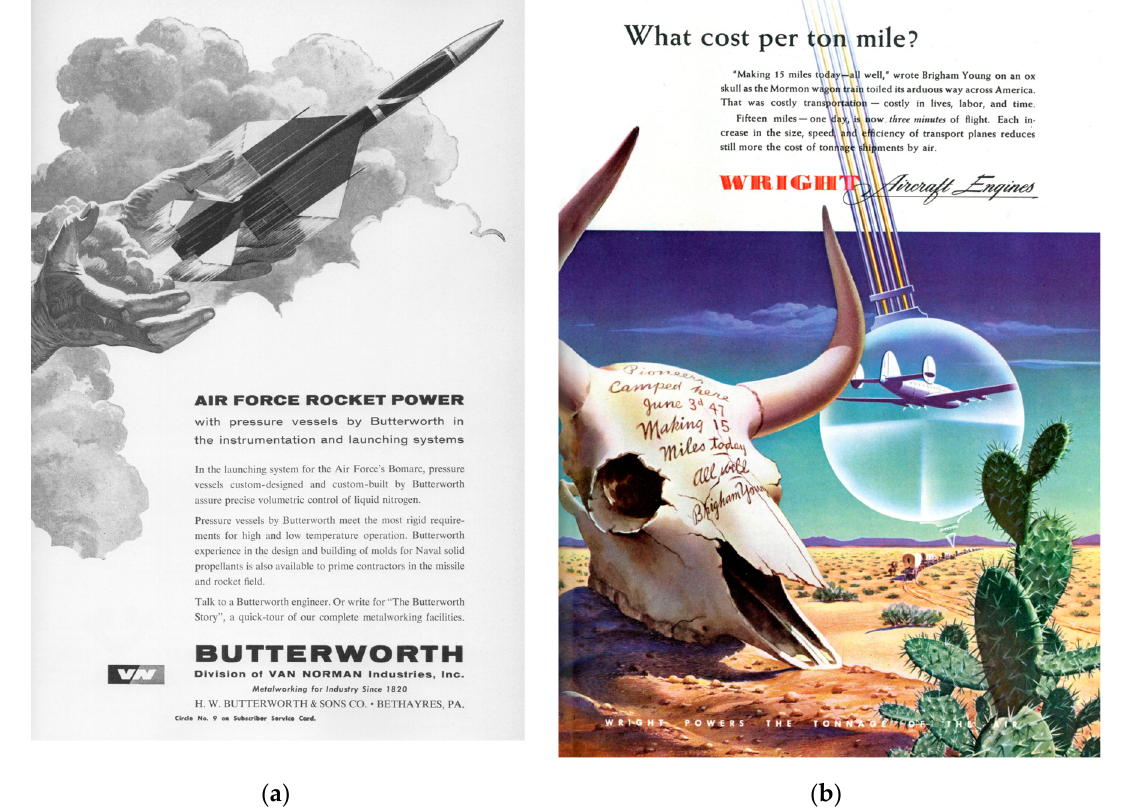
Figure 3. ( a ) The advertisement on the left depicts a gesture of reach calling to mind disembodied spiritual hands surrounded by heavenly clouds is shown in an advertisement for the US Air Force’s Bomarc missile. Missiles and Rockets July 20, 1959. ( b ) The advertisement on the right shows how the aerospace industry has reduced the amount of time it takes to move tonnage by comparing the speed of twentieth-century aircraft, shown encapsulated inside a clock’s pendulum to denote time, to the movement of a nineteen-century wagon train toiling westward along the Mormon Trail. National Aeronautics March 1943 Vol. 21 No. 3.